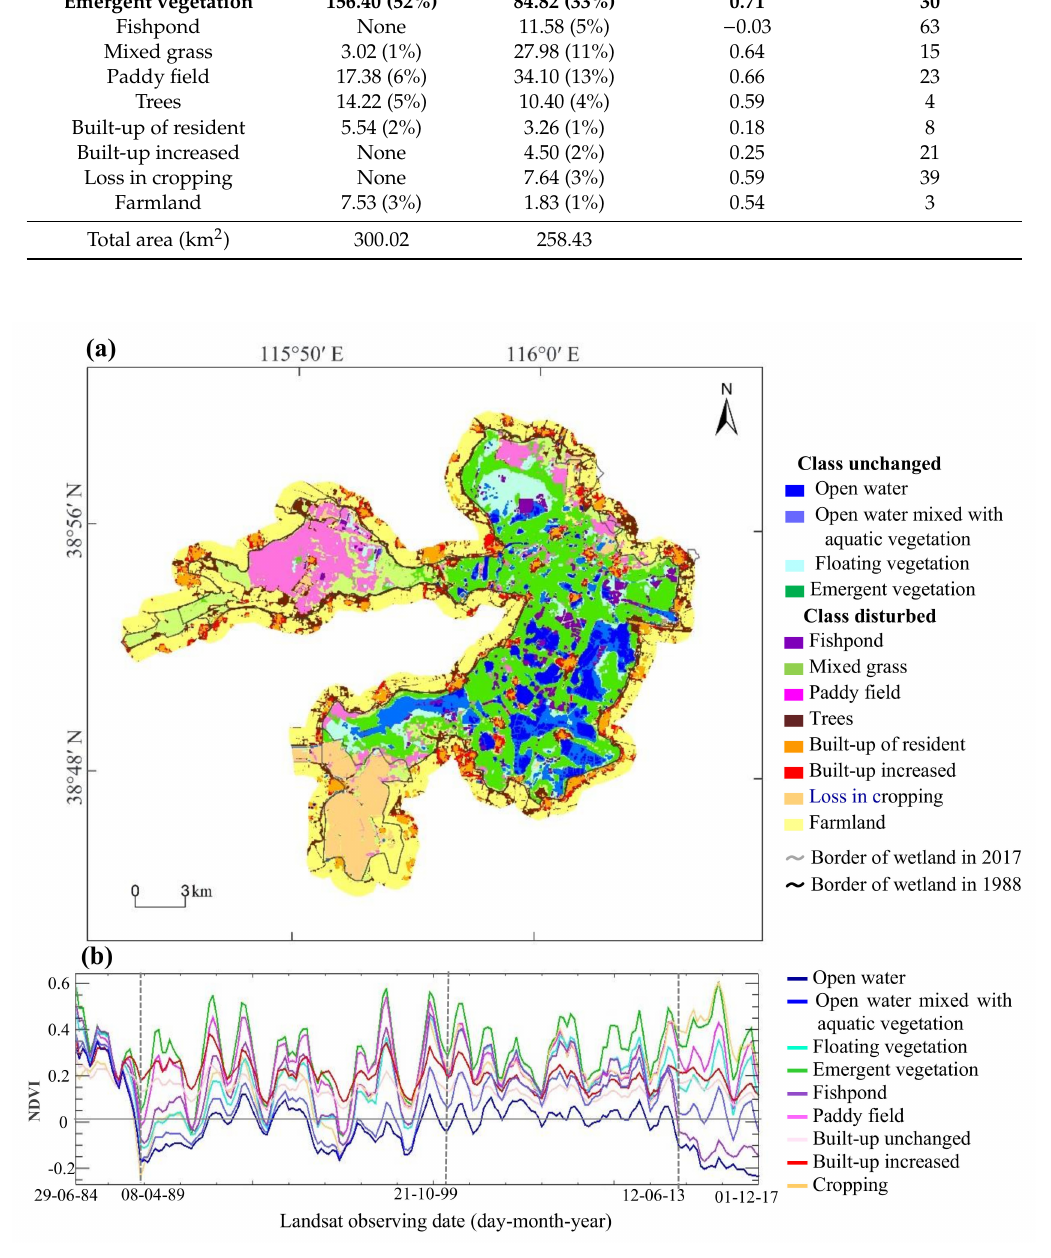
Figure 7. ( a ) The classes of wetland habitats obtained by clustering NDVI time variations from 1984 to 2017 and ( b ) time smoothed variations of averaged NDVI for typical classes across the wetland range of